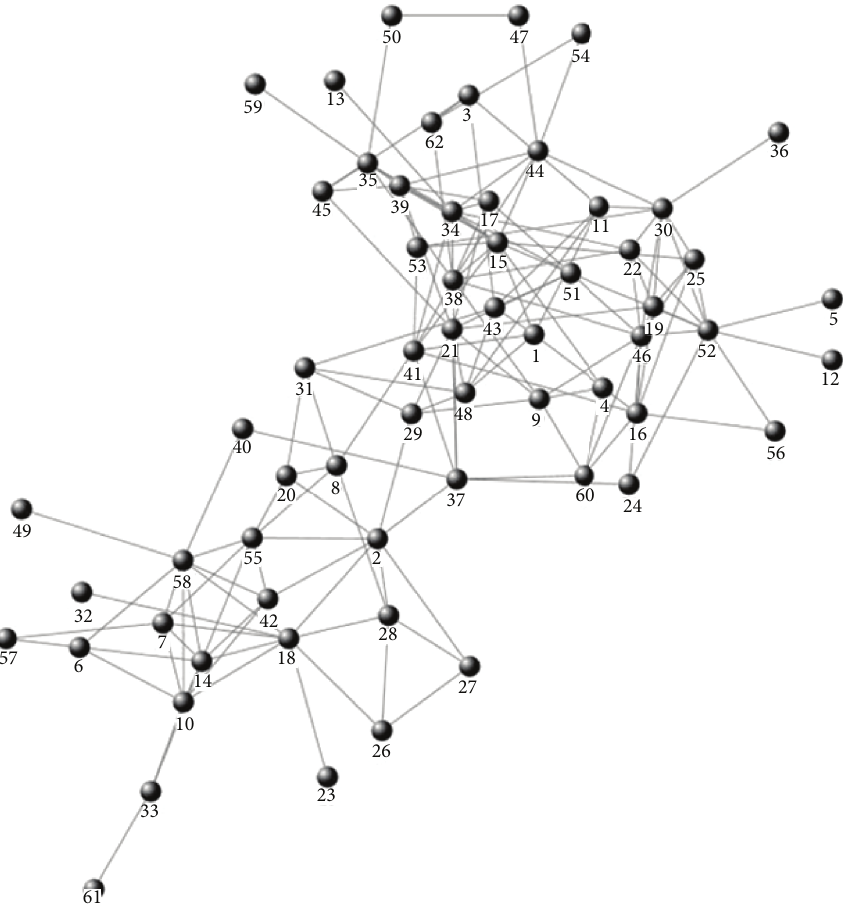
Figure 3: Dolphin social